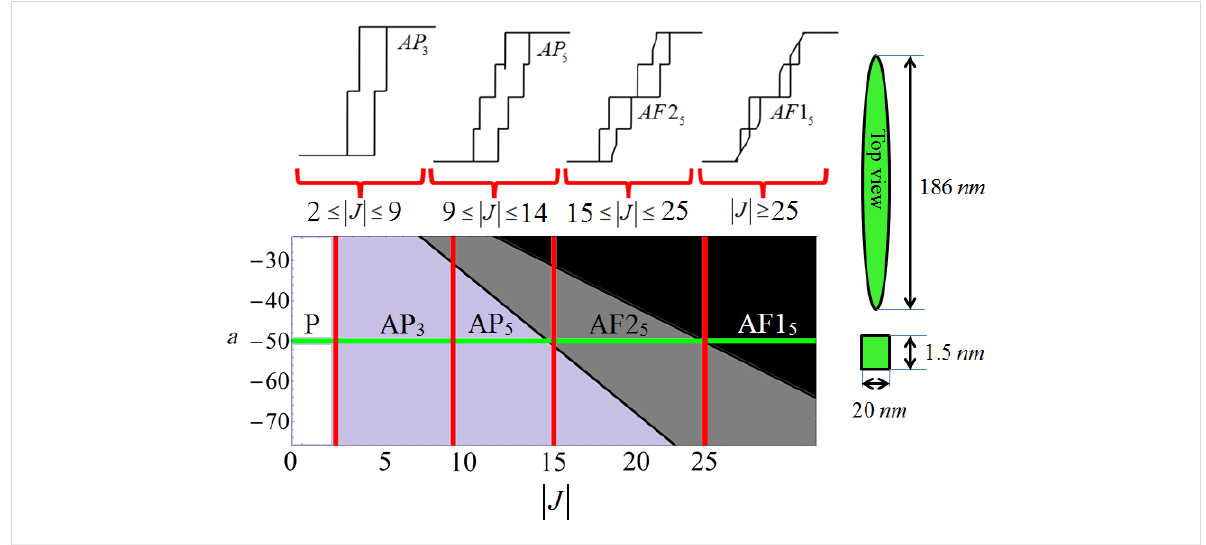
Figure 2: The evolution of four nanomagnets with constant anisotropy and varying interaction strength. Along the top of the plot the shape of the hysteresis, for magnetization against applied field, in a range of J is shown schematically. The anisotropy parameter is taken as a = − 50 (with N x = 0.00454). The green line intersecting the bottom phase diagram represents this constant value of anisotropy. The hysteresis occurs with j plateaus of differing values of , which is the meaning of the subscript of AP j , AF 1 j , and AF 2 j (plateaus of the same value of are given the same index). The hysteresis profiles have been obtained by using a full dynamical analysis using the LLG equations, Equation 6, and compared to the analytically obtained phase diagram that is similar to Figure 1. The plateaus occur at = 0, ±1/2, ±1. When = 0, ( φ 1 , φ 2 , φ 3 , φ 4 ) = (0, π ,0, π ) or ( π ,0, π ,0). For the saturation magnetized states, all the φ are equal. In the cases of = 1/2 the azimuthal angles take the form ( π ,0,0,0) etc. and vice versa for = − 1/2, e.g., ( π , π , π ,0). Each of the nanomagnets has dimensions l x = 186 nm, l y = 20 nm, and l z = 1.5 nm. The top and front view geometry and sizes are shown schematically.